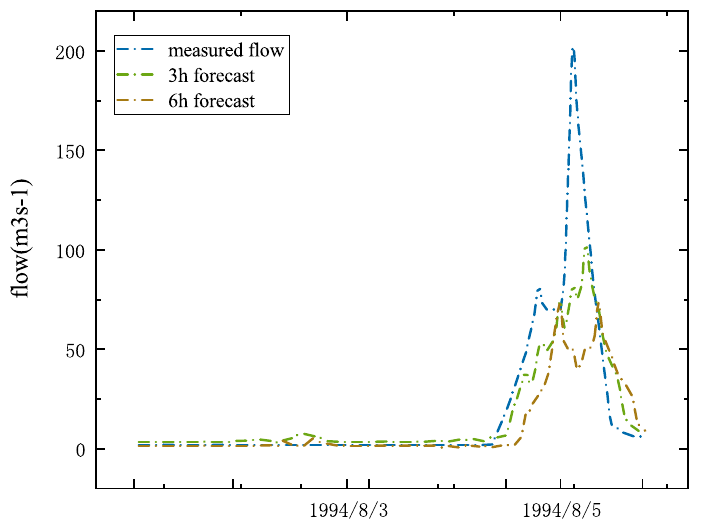
Figure 6. The forecasting process of the No. 19940805 flood. The blue line is the actual measured flow of the Zhaishang site; the green line is the forecast three hours in advance; the brown line is the forecast six hours in advance.